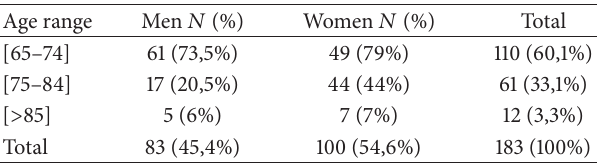
Table 1: Distribution of the study population according to the age range and